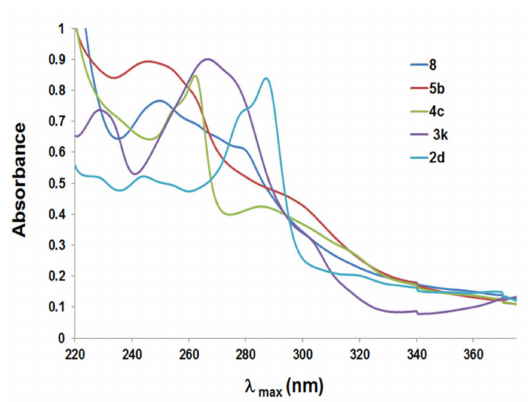
Figure 6. UV–VIS spectra of 9-methyl-2-methylthio-5-deazaalloxazine ( 2d ), 2-butylamino-9-methyl- 5-deazaalloxazine ( 3k ) , 9-methyl-2-(morpholin-4-yl)-5-deazaalloxazine ( 4c ), 2-amino-9-methyl- 5-deazaalloxazine ( 5b ) and 2-deoxo-5-deazaalloxazine ( 8